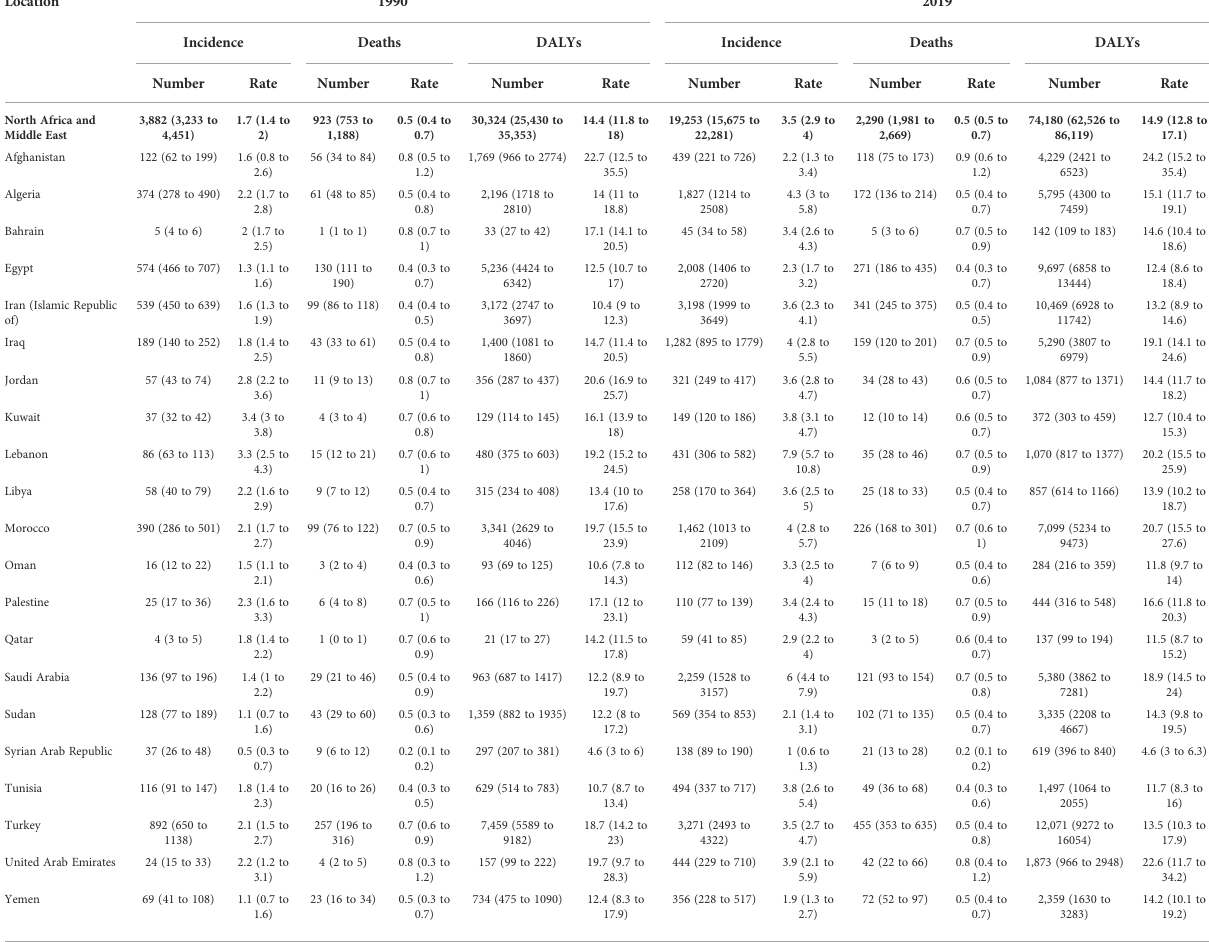
TABLE 1 Incidence, deaths, and disability-adjusted life year (DALY) number and rate of thyroid cancer in North Africa and Middle East regions among both sexes in 1990 and 2019, by country. Location